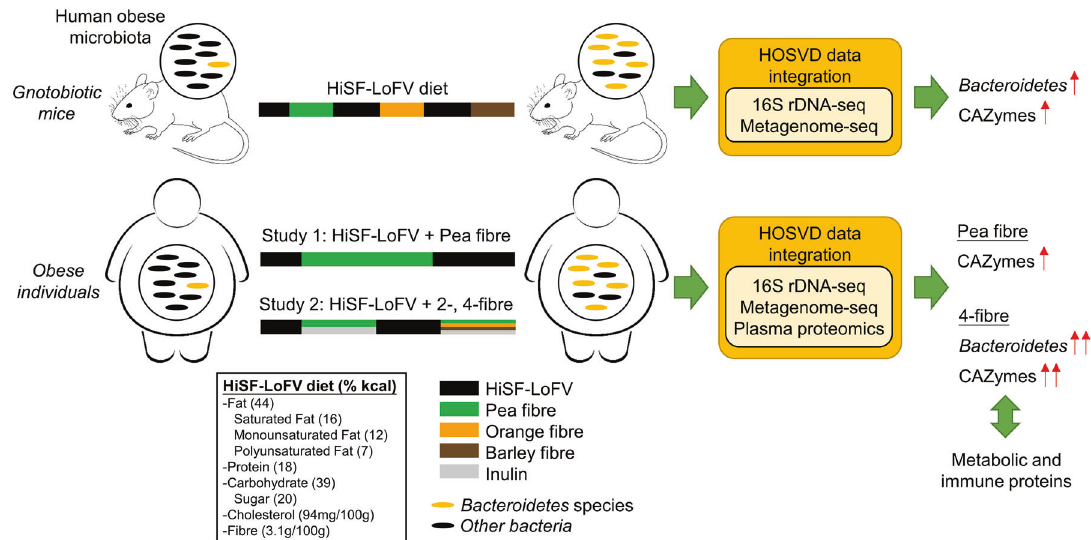
Fig. 1 Co-clinical trial in gnotobiotic mice and obese individuals showed that targeted prebiotics alter the obese microbiome. In this study, the authors tested the effect of fi bre supplementation regimens in (1) germ-free mice colonized with faecal microbiomes from obese individuals; and (2) obese or overweight subjects. Multiomic analysis demonstrated that speci fi c fi bre treatments lead to enriched bene fi cial Bacteroidetes species and is correlated with an altered physiological